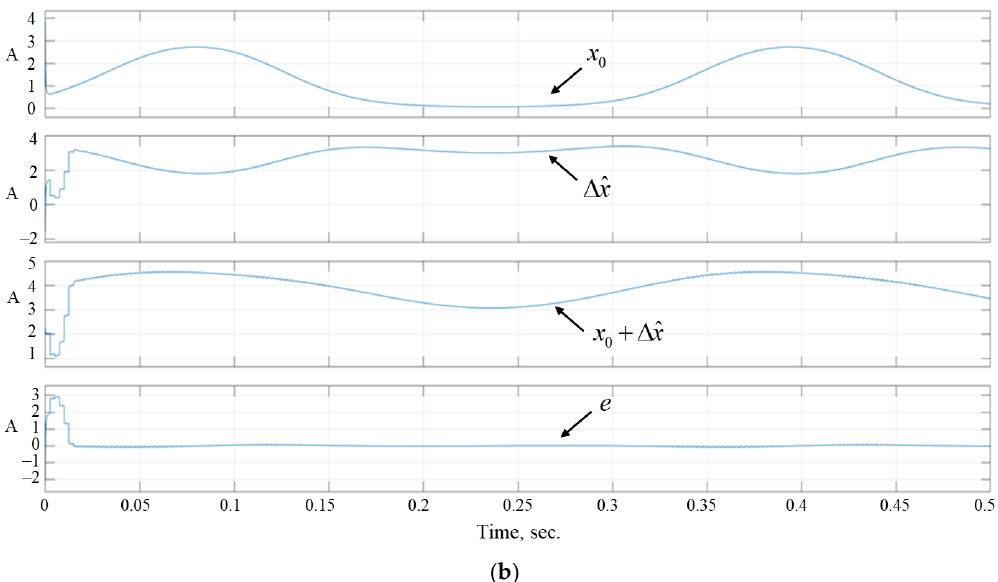
Figure 14. Simulation results for the variations in the ambient temperature: ( a ) the signals of temperature, output current, voltage, and power, ( b ) the MPPT control signals.